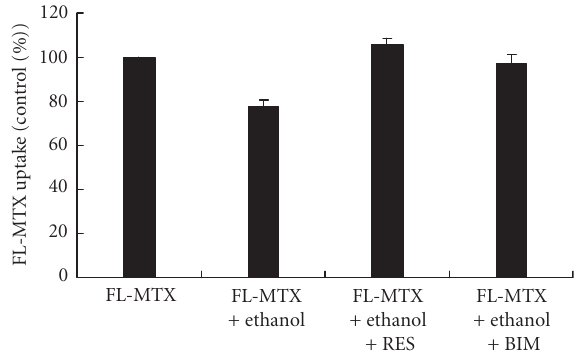
Figure 5: Fluoroskan studies of FL-MTX (10 μ M) uptake by HPT cells in 24 well plates treated with ethanol (500mg/dL), ET- B receptor antagonist (RES-701-1) (10 μ M), and PKC selective inhibitor (BIM) (2.5 μ M). Inhibition of FL-MTX uptake is reversed by the addition of RES-701-1 or BIM. Data are expressed as mean ± SEM ( n =